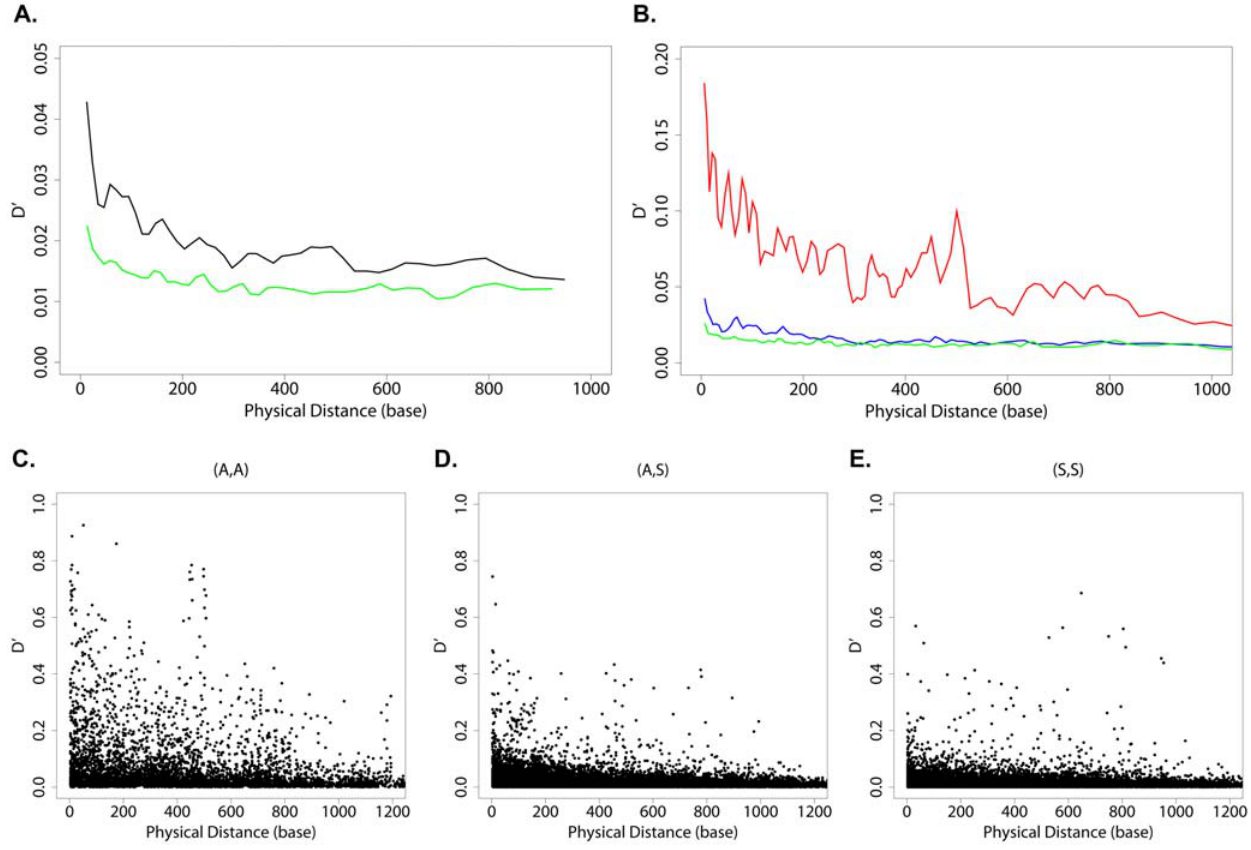
Figure 2. (A,A) Covariation Is Dramatically Higher Than (A,S) and (S,S) Covariation in the Specialty Dataset. (A) Sliding window results of average D 9 . All mutation pairs, black; silent mutation pairs (S,S) only, green. Each sliding window contains 4% of the data points in the set. (B) Sliding window results of average D 9 . Amino acid mutation pairs (A,A), red; amino acid mutations to silent mutations (A,S), blue; silent mutation pairs (S,S), green. Each sliding window contains 2% of the data points in the set. (C–E) Plots of D 9 against the physical distance (base) within the mutation pair for C) (A,A), D) (A,S) and E) (S,S).